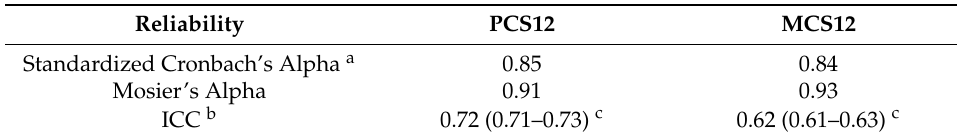
Table 2. Internal Consistency and Test-Retest Reliability of the Medical Outcomes Study Short Form-12 Version 2 (SF-12v2).